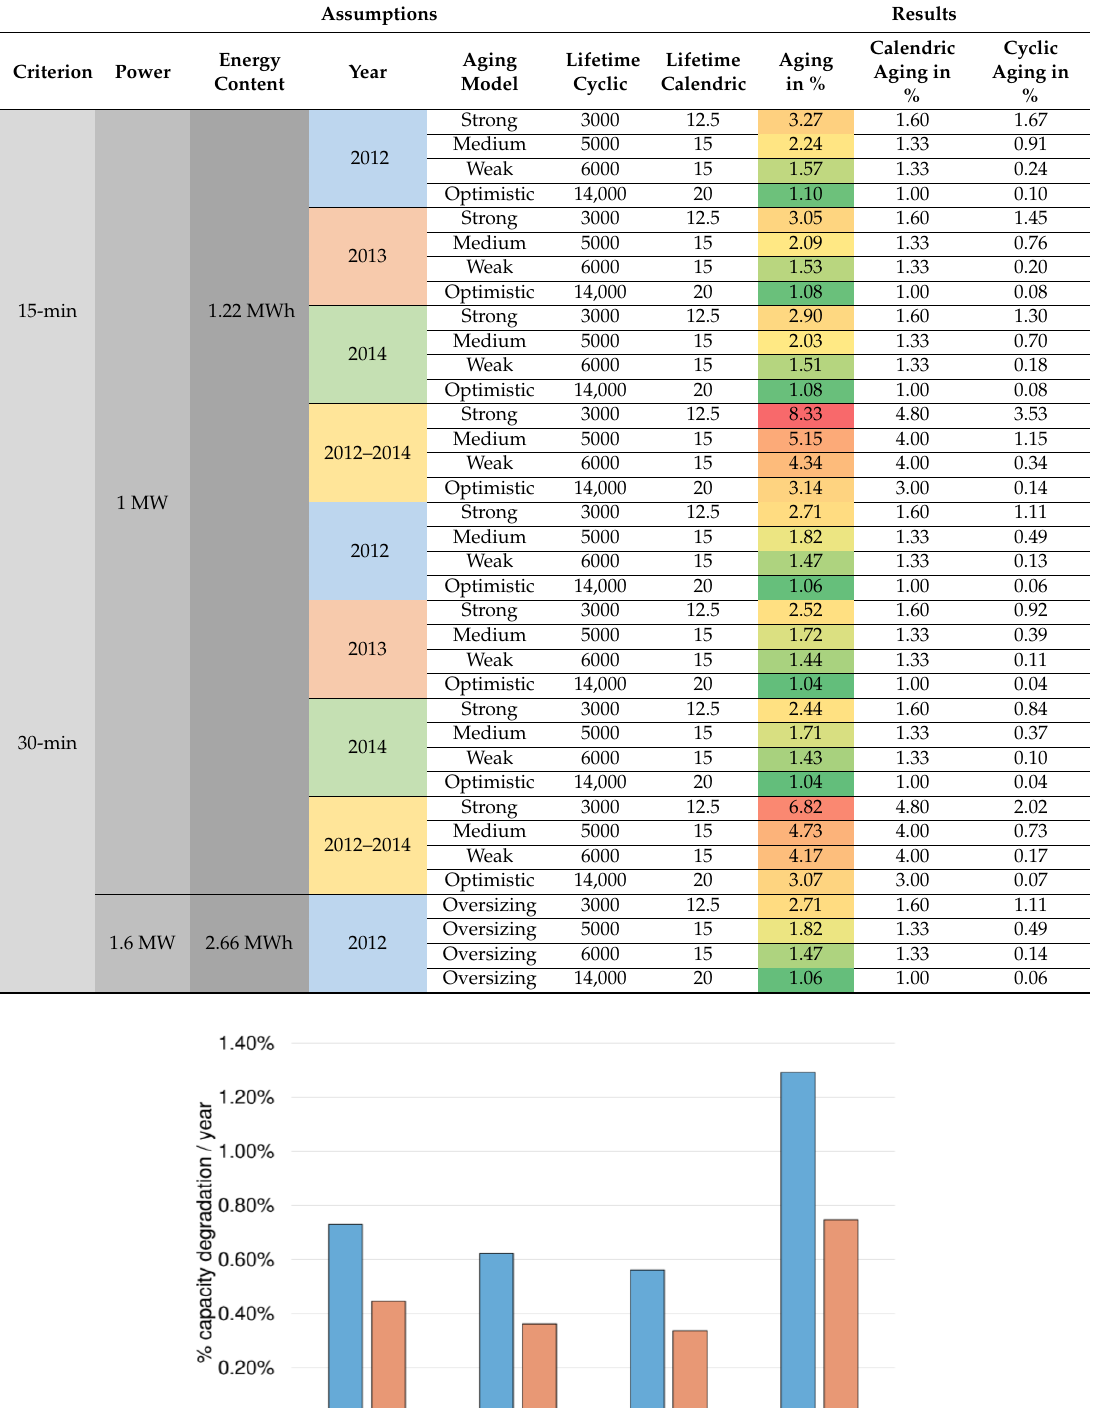
Table 10. Assumptions and results for the given aging scenarios with BESS property sensitivity according to cyclic and calendric aging.